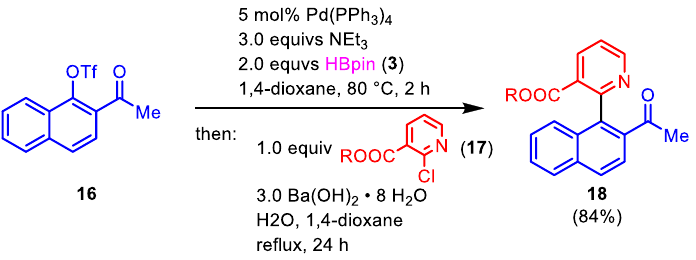
Figure 12. Levacher’s one-pot MBSC synthesis of 2-naphthylpyridine 18 [40].